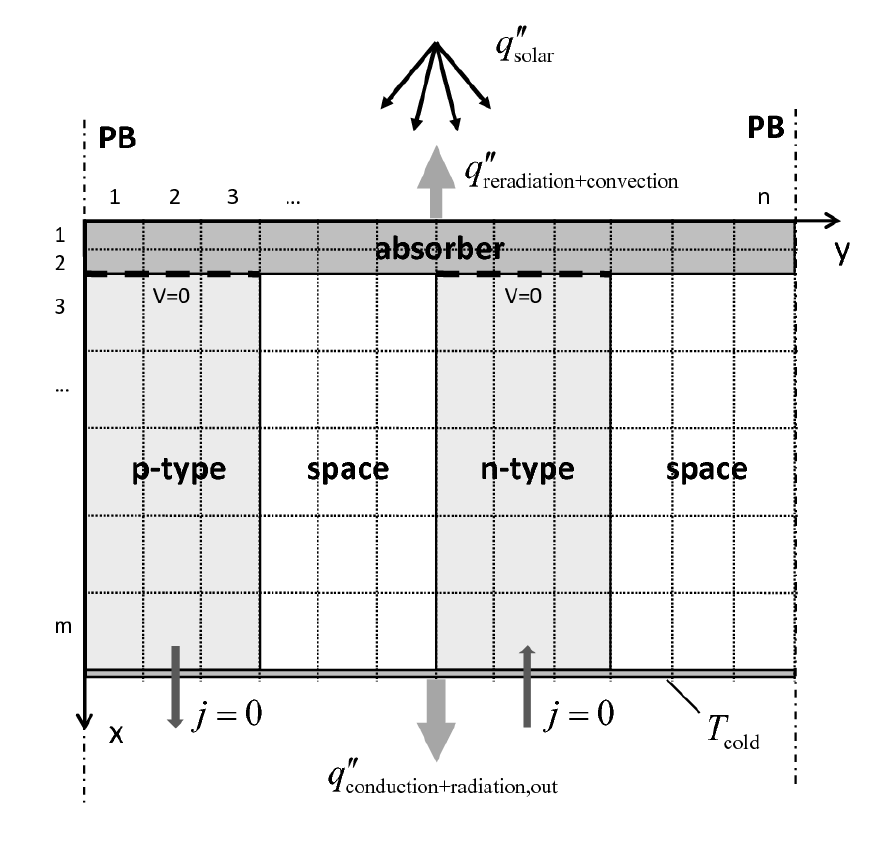
Figure 7. Scheme of the model domain (divided into m × n cells). Indicated are the boundary